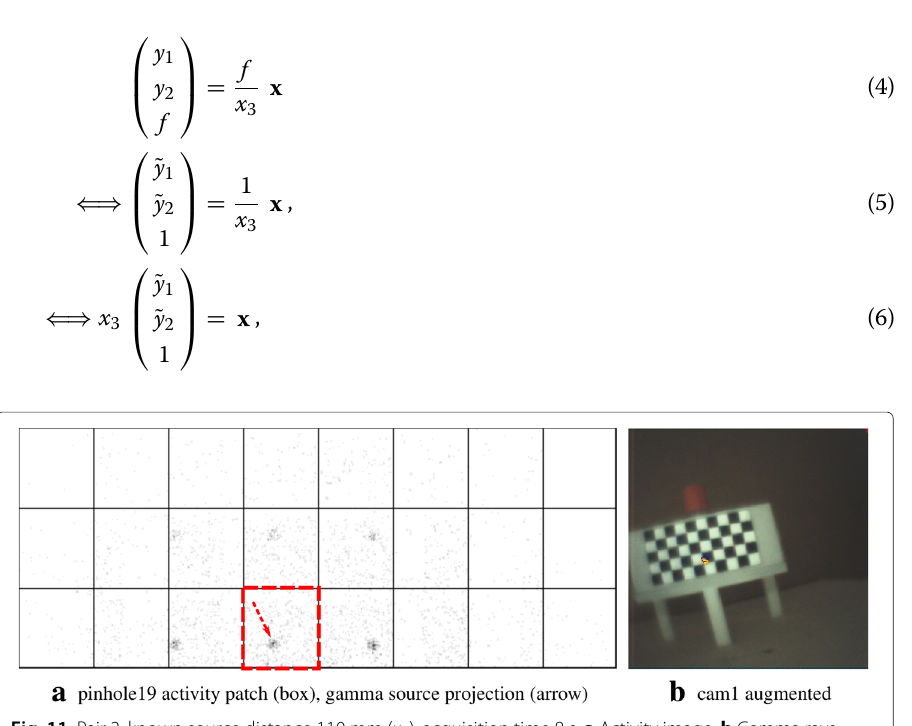
Fig. 11 Pair 2, known source distance 110 mm ( x 3 ), acquisition time 8 s. a Activity image. b Gamma rays emanate near the exit